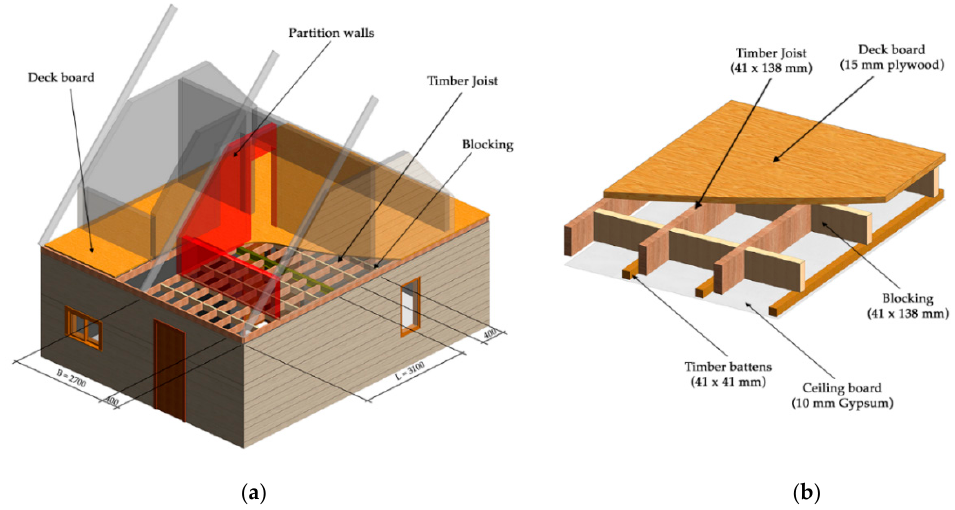
Figure 6. ( a ) Layout and dimensions of the Field-3.1-W timber floor.; ( b ) Ceiling-to-joist connections of the Field-3.1-W timber floor